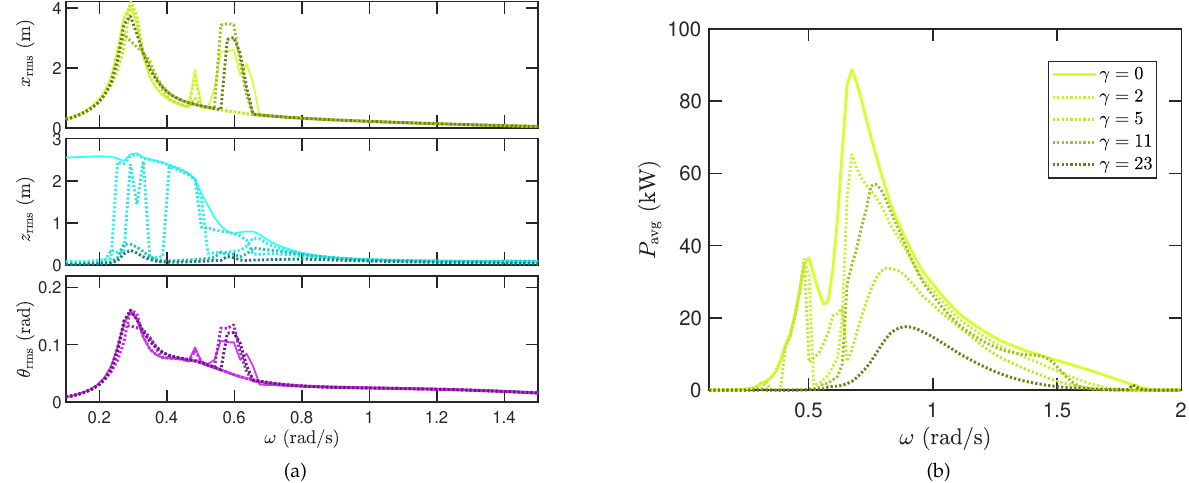
Fig. 12. The RMS of the motion (12a) and the time-averaged power (12b) for the 3-DOF scenario and varying γ (indicated by varying shade) where the PTO conditions are locally optimized for each frequency.